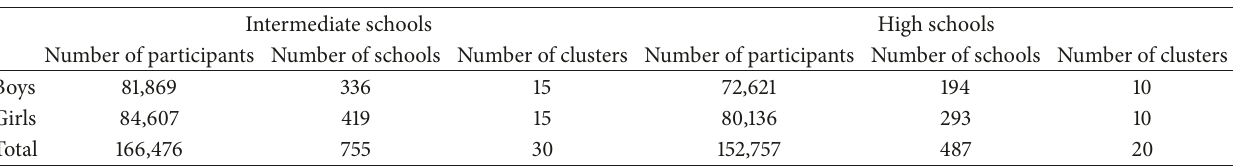
Table 1: Sampling frame for determining the prevalence of bleeding symptoms.